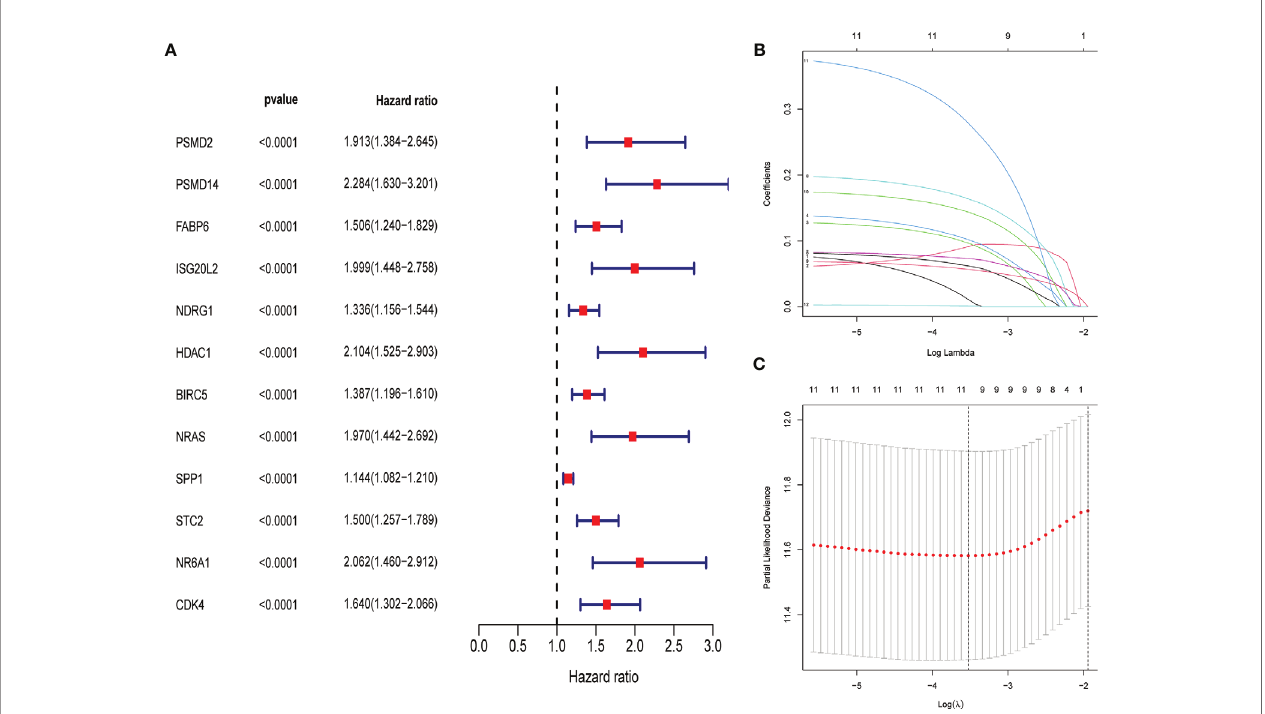
FIGURE 3 | (A) Forest map of 12 immune genes related to the prognosis of hepatocellular carcinoma, analyzed by univariate Cox regression, all 12 genes are high risk genes (HR >1, P < 0.0001). (B) LASSO coef fi cient spectrum of 12 immune genes, Generate a coef fi cient distribution map for a logarithmic ( l ) sequence. (C) Selecting the best parameters for LIHC in the LASSO model ( l